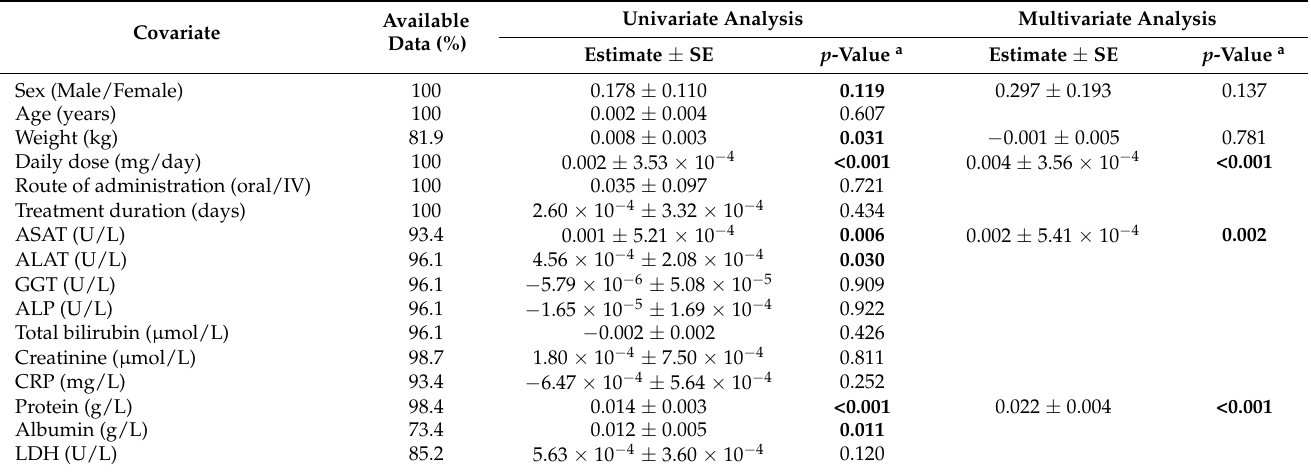
Table 2. Factors that contribute to the variability of ISA